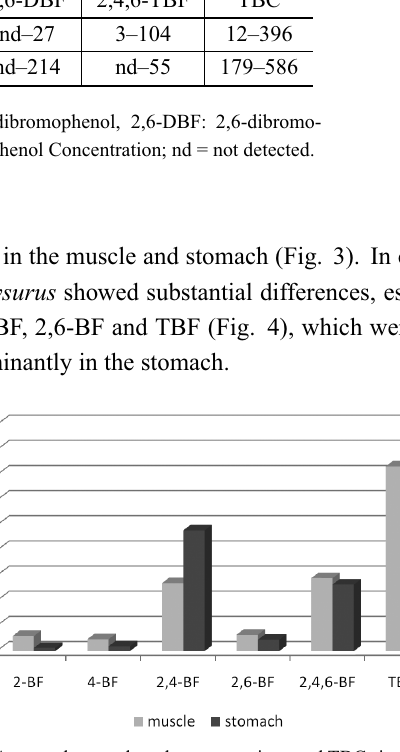
Fig. 3 – Average bromophenol concentrations and TBCs in the muscle and stomach of L. synagris .